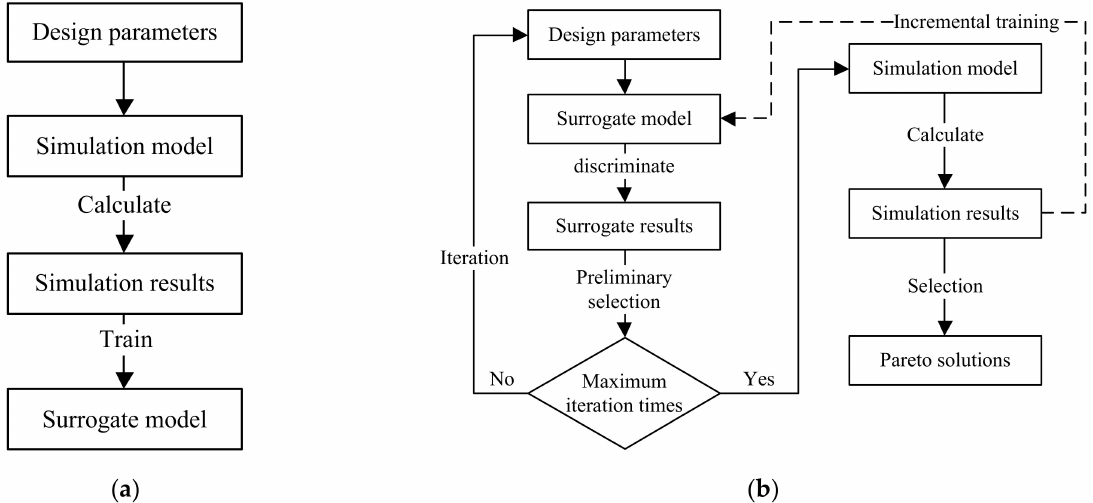
Figure 1. Flowchart of data-driven evolutionary optimisation (DDEO). ( a ) Initial training process of surrogate model; ( b ) DDEO in online